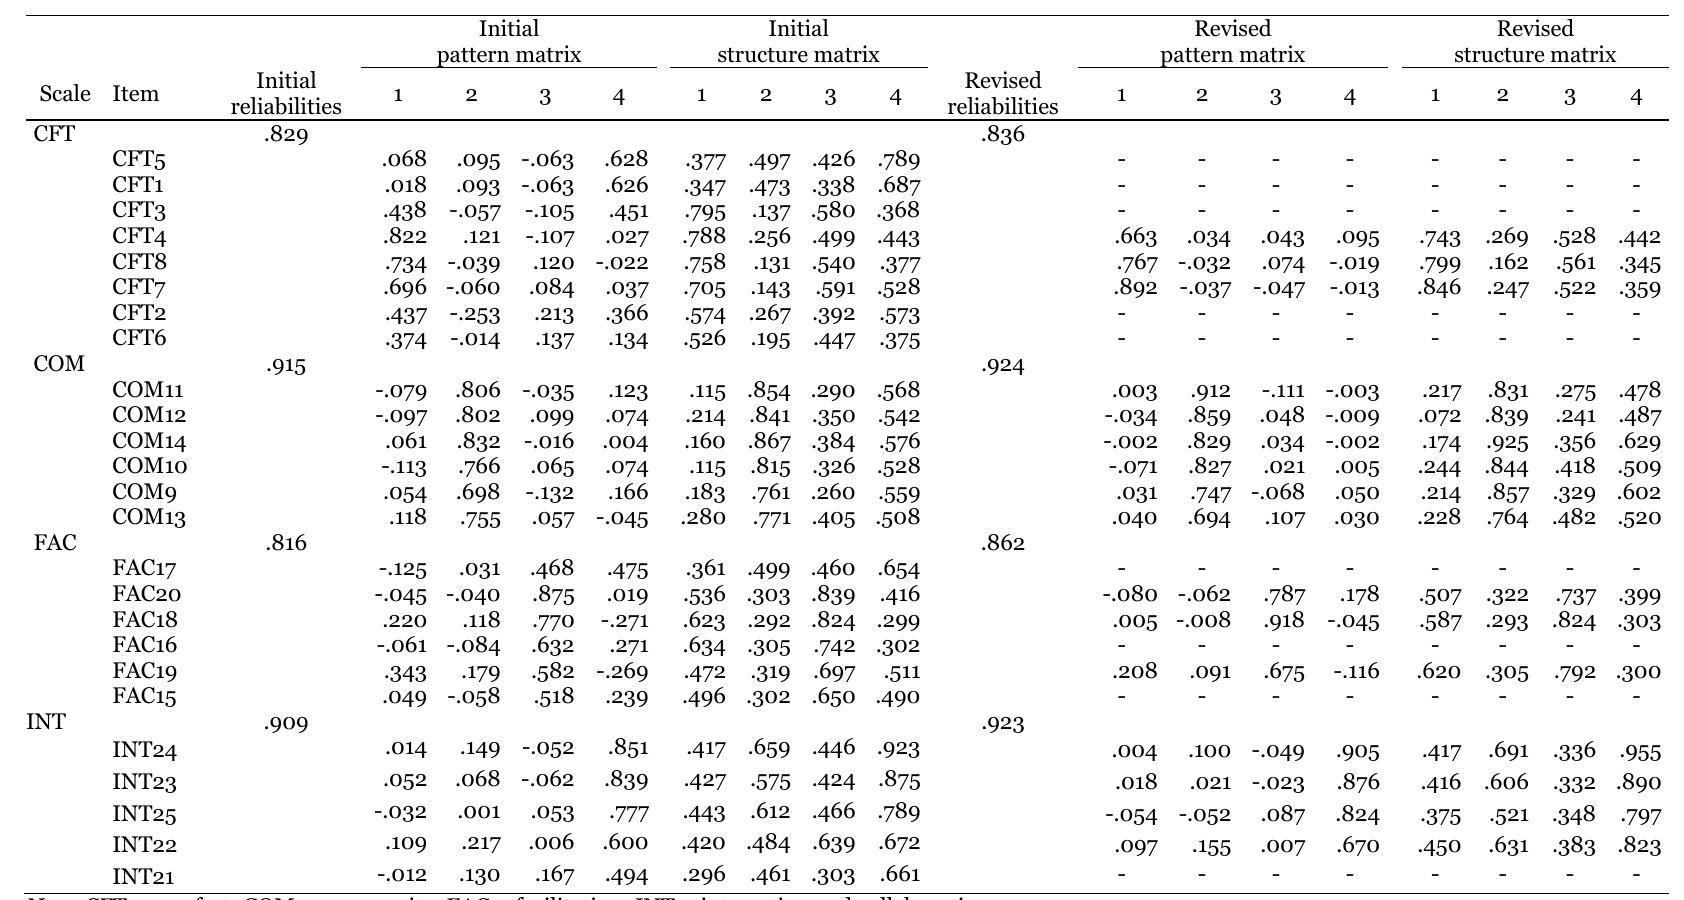
EFA Pattern/Structure Matrix and Reliabilities for Original and Revised